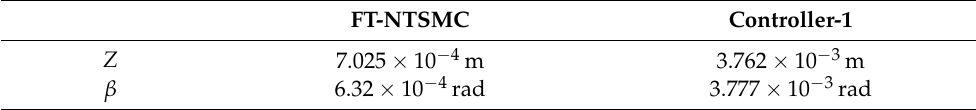
Figure 8. The experimental results of the tracking errors of the end-effector. Table 5. Maximum steady-state errors of the